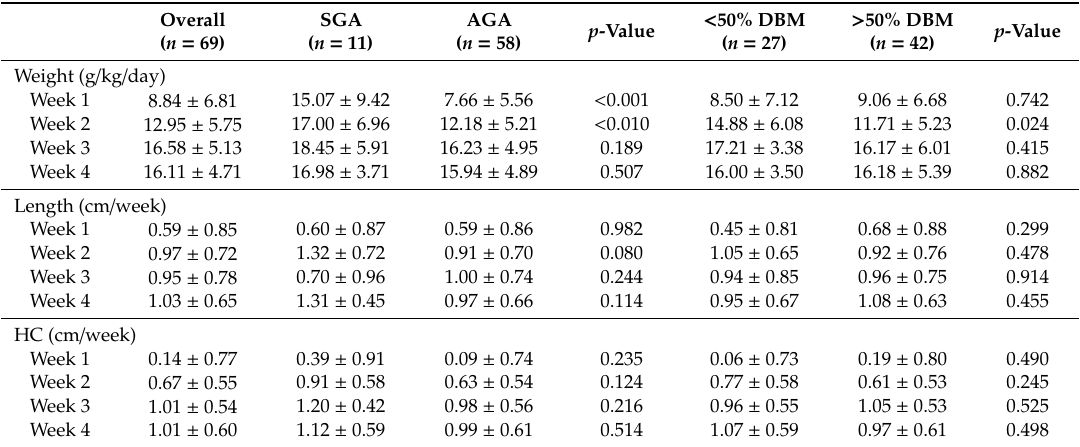
Table 4. Weekly growth velocities including subgroups by small for gestational age (SGA) status and DBM intake. Mean ± SD.